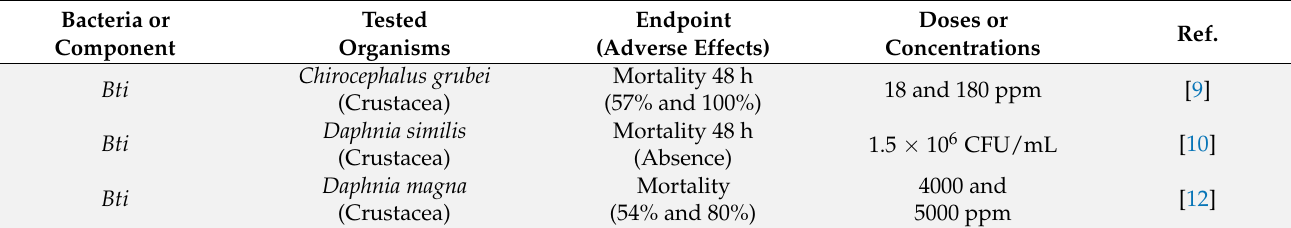
Table 1. Aquatic and terrestrial ecotoxicity of bacteria-based